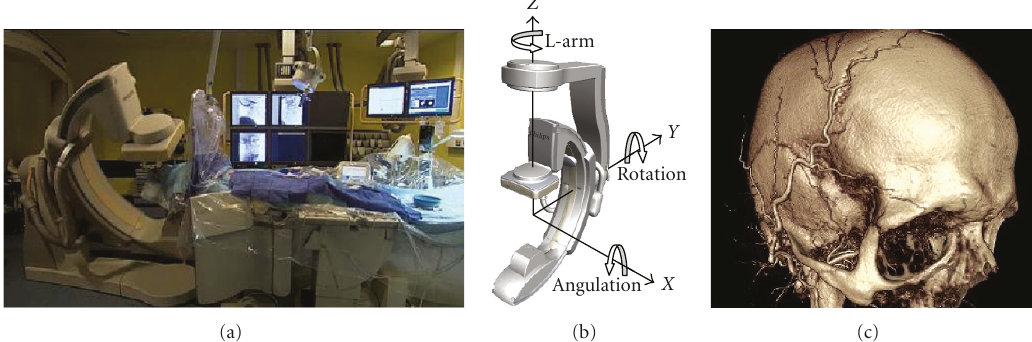
Figure 1: (a) The X-ray C-arm system in a clinical intervention. (b) The degrees of rotational freedom of the C-arm geometry. (c) A 3D data set, acquired using the X-ray C-arm